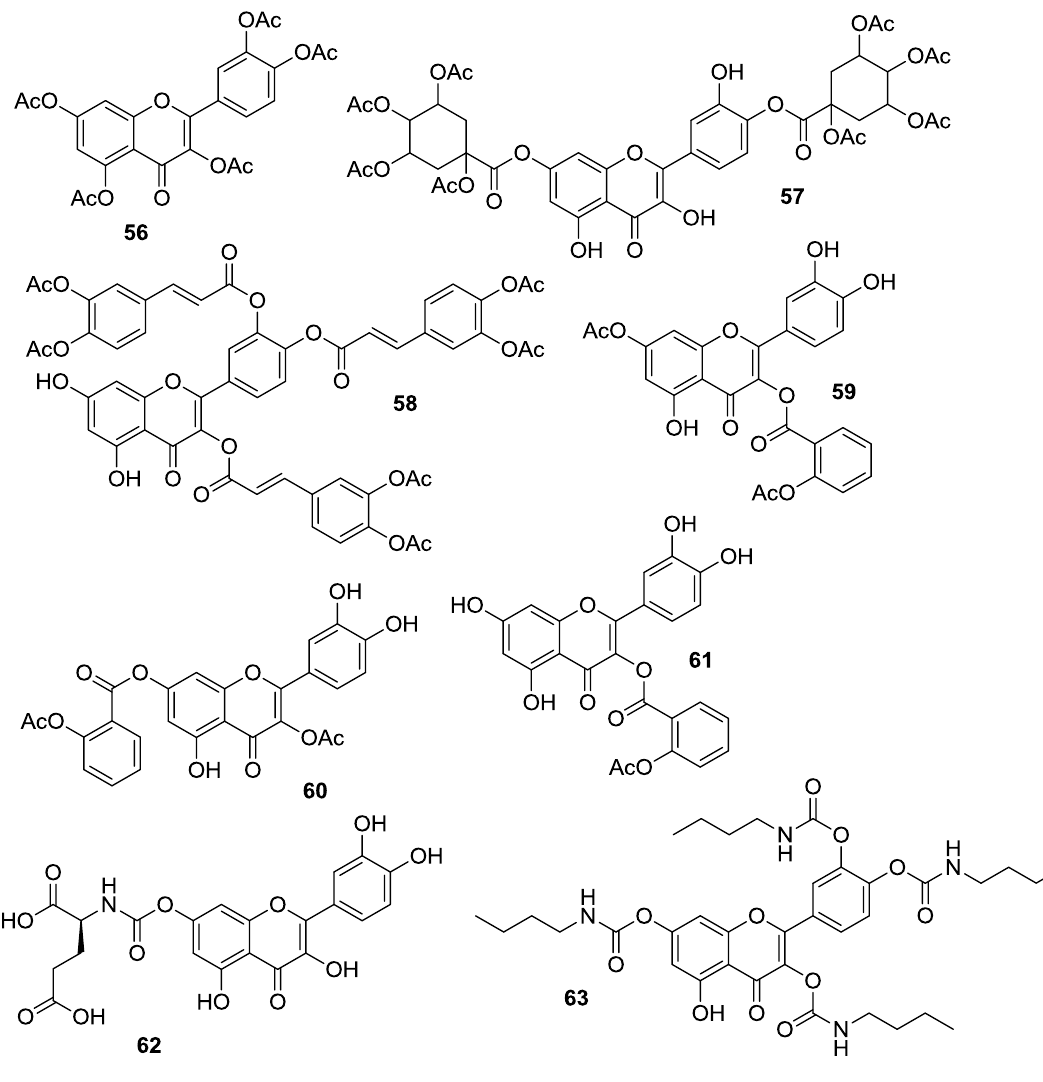
Figure 8. Structures of O -acylated quercetin derivatives 56 – 63 . Table 10. Cytotoxic data of analogs 56 – 61 compared to quercetin 1